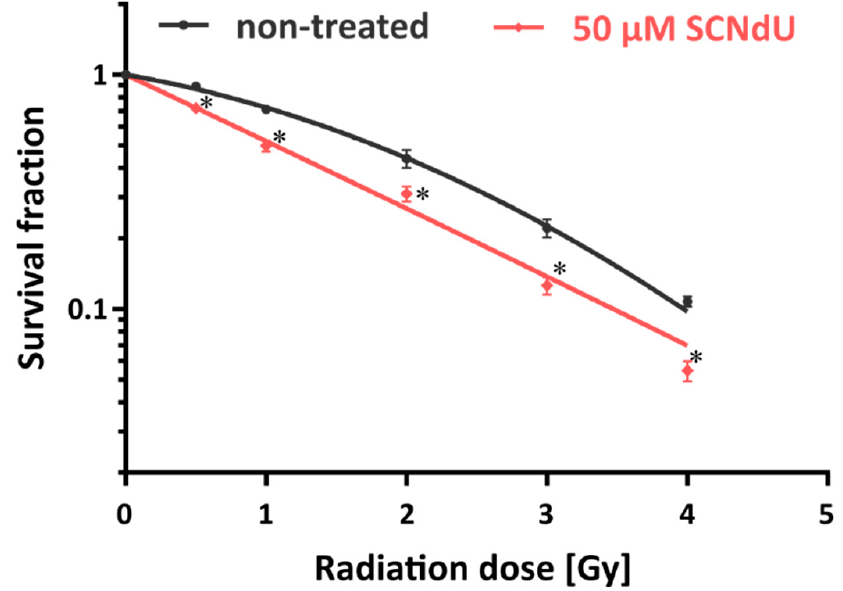
Figure 2. Dose–response curves of PC3 cells treated with 50 µM SCNdU or without SCNdU. Experiments were performed in three independent experiments in triplicate, and the results are expressed as mean ± SD. * significant difference compared with the untreated variants, p < 0.05.